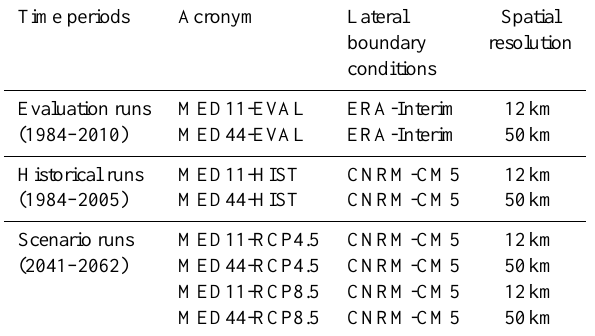
Table 1. Description and time periods for the different simulations of the ALADIN-Climate Regional Climate Mode used in the current